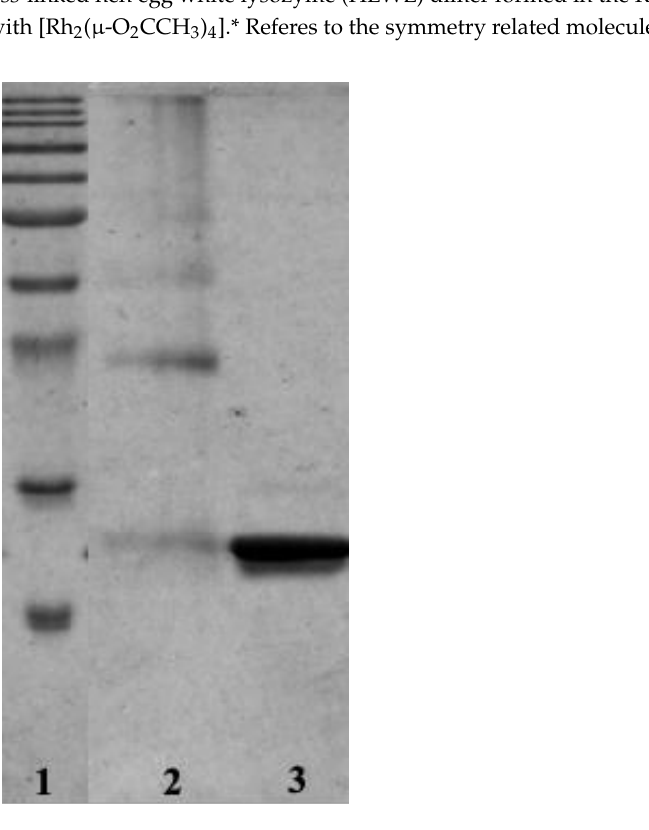
Figure 6. SDS-PAGE analysis of dissolved Rh/HEWL crystals. Line 1, markers; Line 2, dissolved Rh/HEWL crystals; and Line 3, dissolved metal-free HEWL crystals.